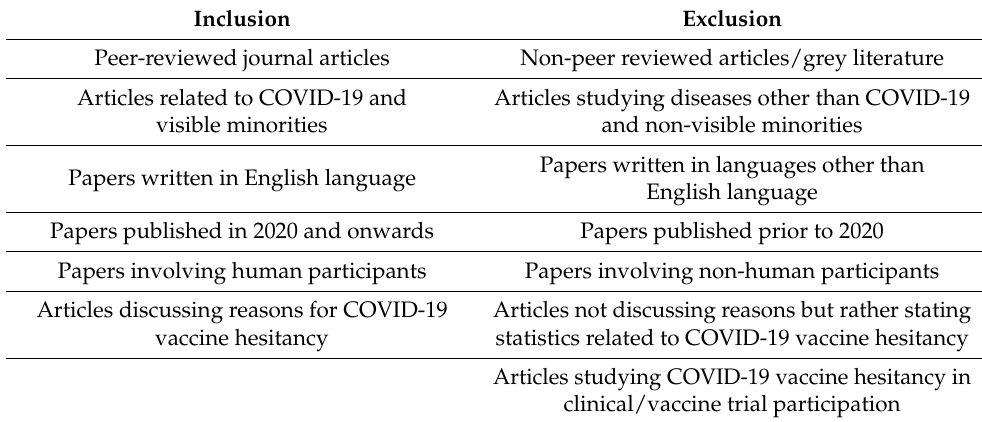
Table 1. Inclusion and exclusion criteria.